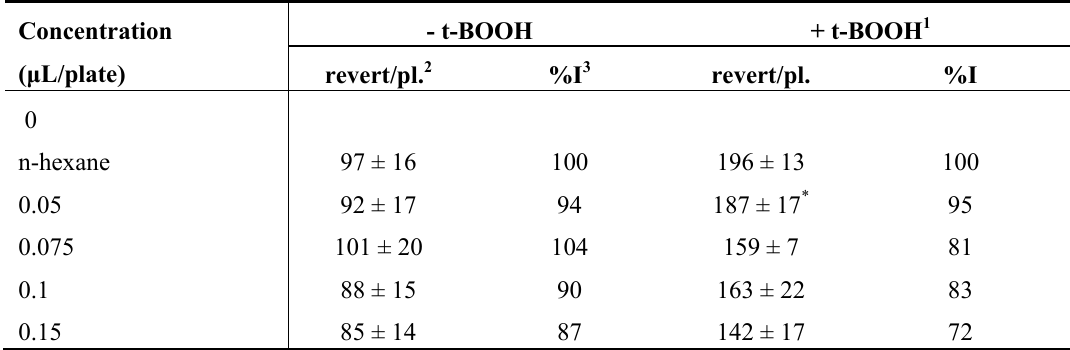
Table 4. Effect of Myrtus communis essential oil on spontaneous and t -BOOH-induced mutagenesis in